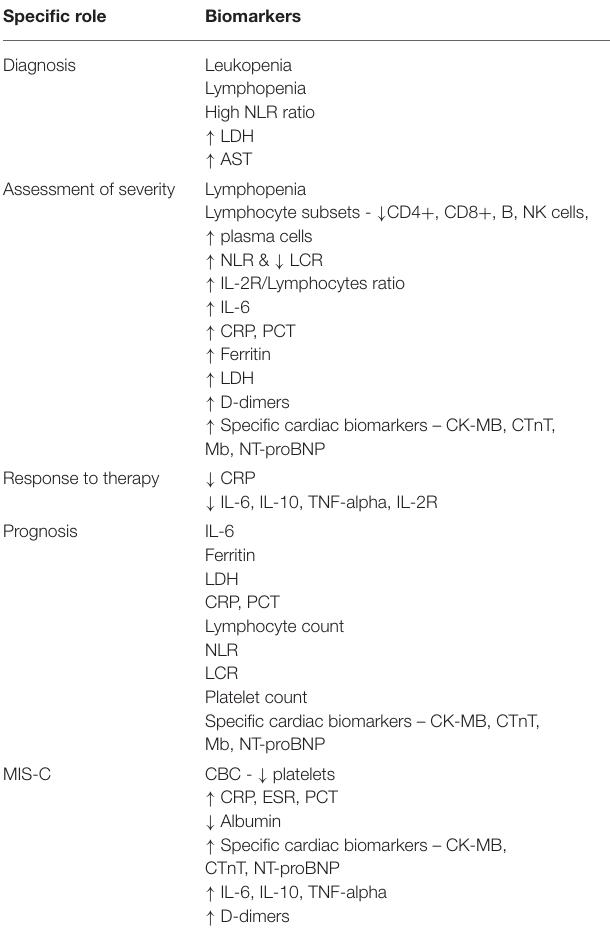
TABLE 4 | Role of biomarkers in various areas of patient management. Specific